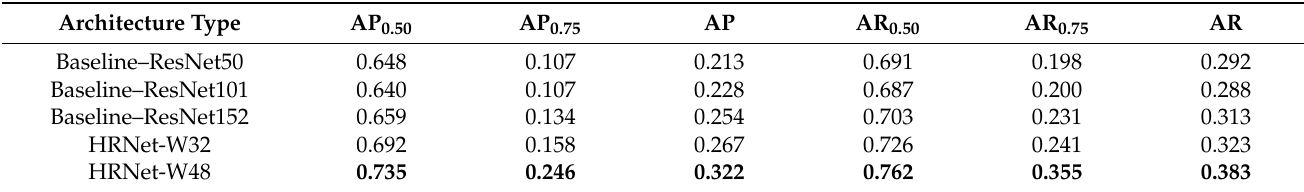
Table 2. Object keypoint similarity metrics (OKS) resulting from the different keypoint detection models stating the average precision with threshold values of 0.50 (AP 50 ) and 0.75 (AP 75 ) and averaged over thresholds from 0.5 to 0.95 (AP) as well as the average recall with the threshold values of 0.50 (AR 50 ) and 0.75 (AR 75 ). These were averaged over thresholds from 0.50 to 0.95 (AR). Best-performing values are printed in bold.